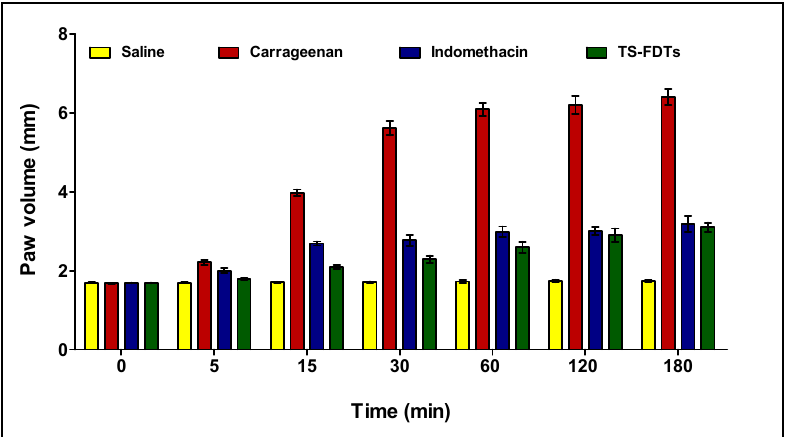
Figure 9. Changes in the paw volume at different time intervals in carrageenan ‐ induced paw edema rat model. Data are presented as Mean ± SD ( n = 6).